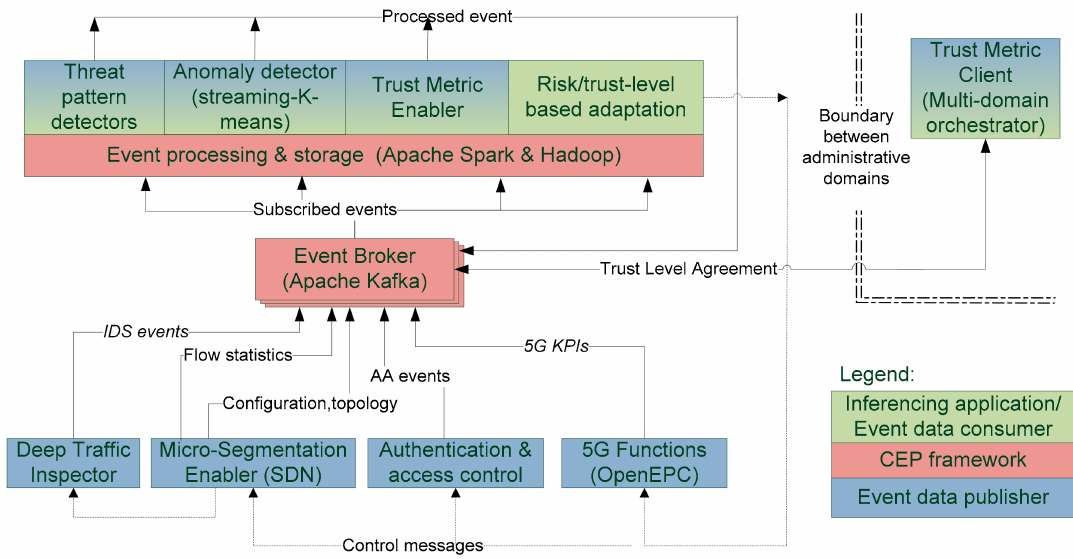
Figure 7. Framework for distribution of security event information—showing technology selections for prototype implementation (updated from the user manual of the monitoring enabler [48]). EPC: Evolved Packet Core; CEP: Complex Event Processing; AA: Authentication and Authorization; IDS: Intrusion Detection